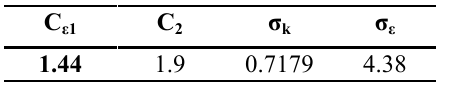
Table 3. Constant values of K- ε realizable